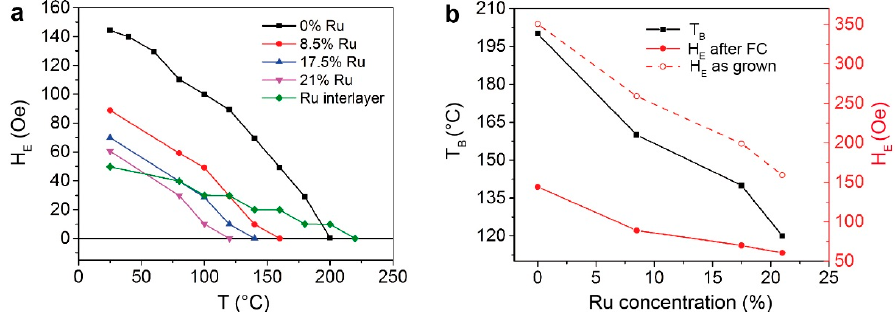
Figure 2. ( a ) Exchange bias field as a function of temperature at different Ru concentrations on top-pinned samples (A series); ( b ) Effect of different Ru concentrations on the blocking temperature and exchange bias field for top-pinned samples.